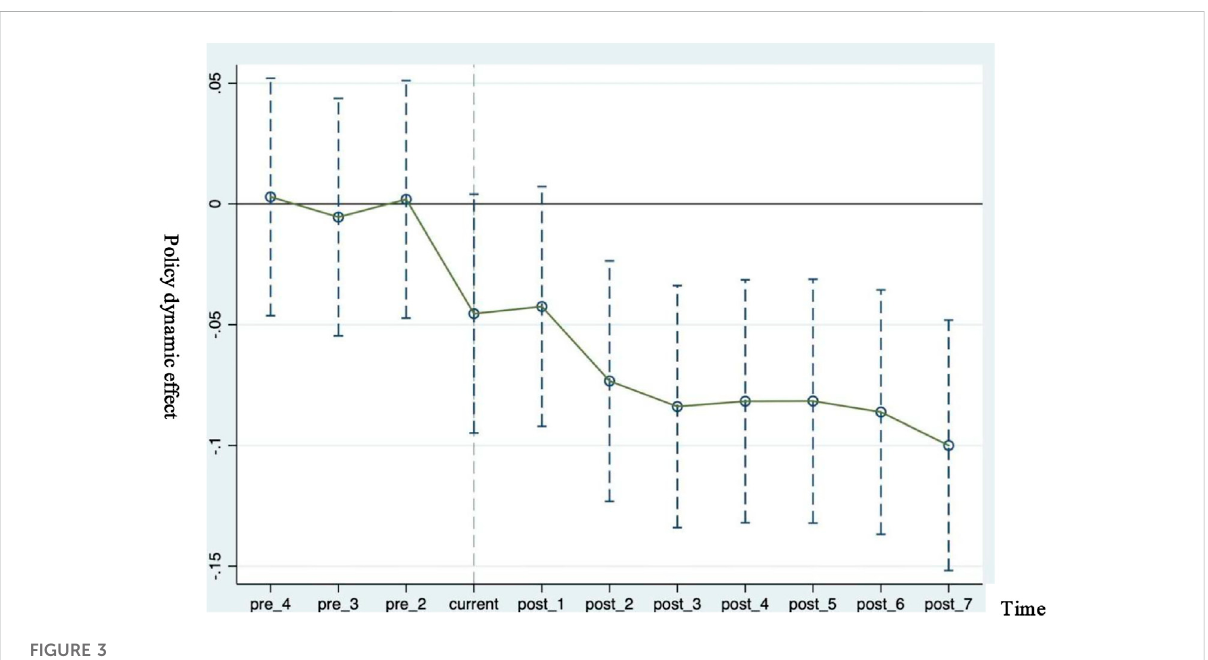
FIGURE 3 Parallel trend hypothesis test.